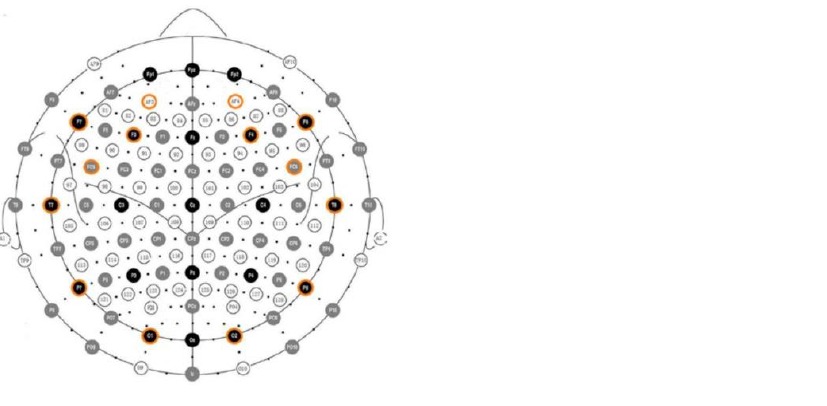
Table 2. Tasks performed by participants.